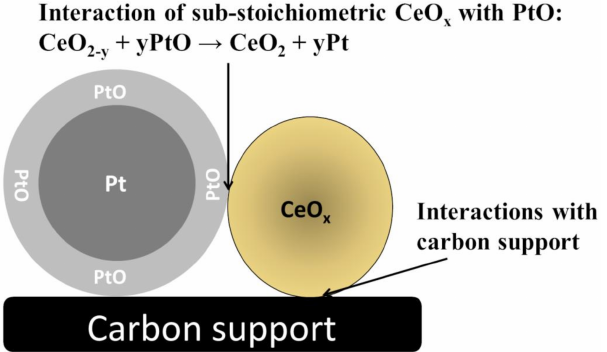
Figure 4. Importance of specific interactions of substoichiometric CeO x (having Ce III and Ce IV ionic sites) with platinum oxo-species (diminishing formation of PtO or PtOH on catalytic Pt [29,32]) and carbon support (suppressing its